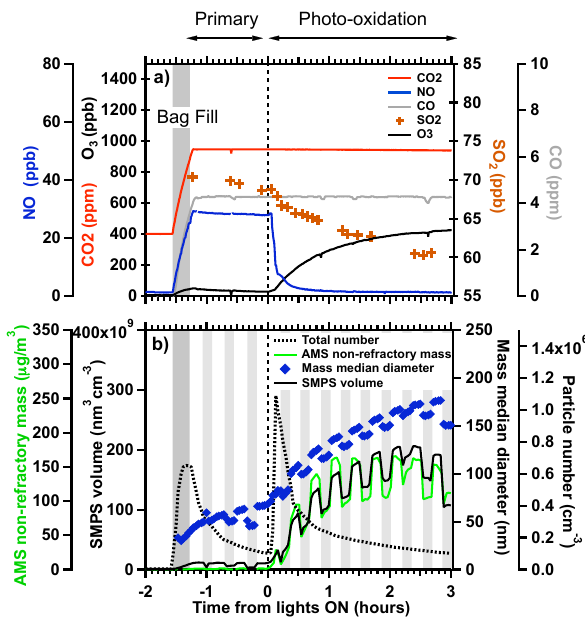
Fig. 2. Time series of (a) gas and (b) particle-phase concentrations measured during a photo-oxidation experiment conducted at 4% engine load. Vertical gray bars indicate period when bag is filled with exhaust or when the aerosol was passed through the thermod-